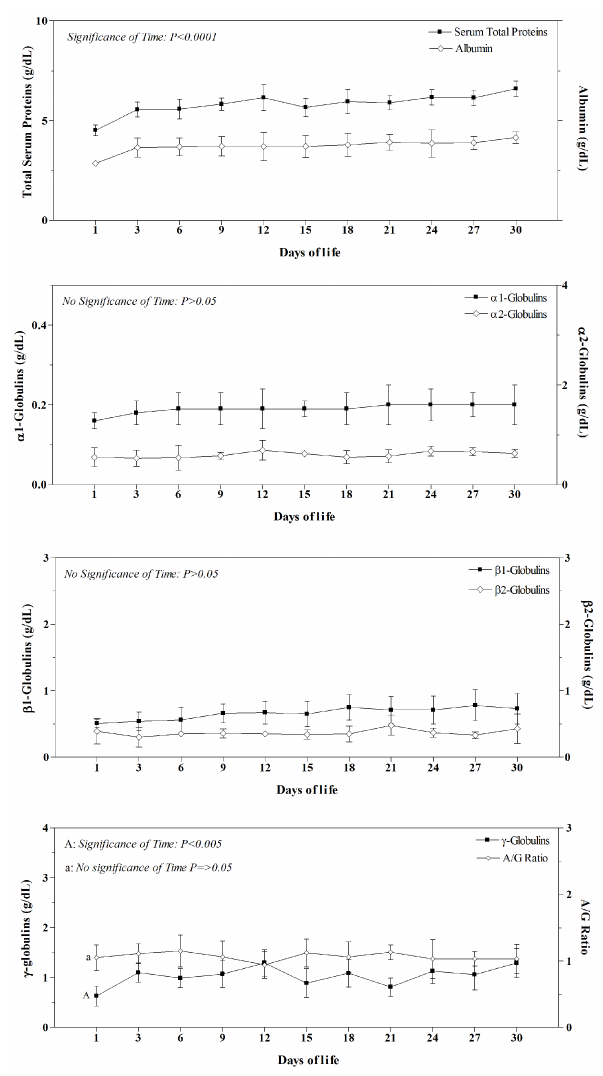
Figure 1. The pattern of serum total proteins, albumin, α 1-, α 2-, β -, γ -globulins and Ratio A / G observed during the first month of life in nine growing